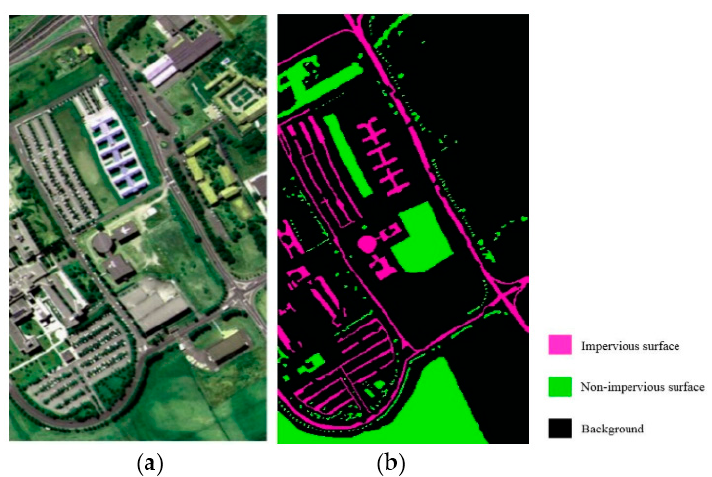
Figure 2. University of Pavia: ( a ) false color composite image; and ( b ) the reference image.